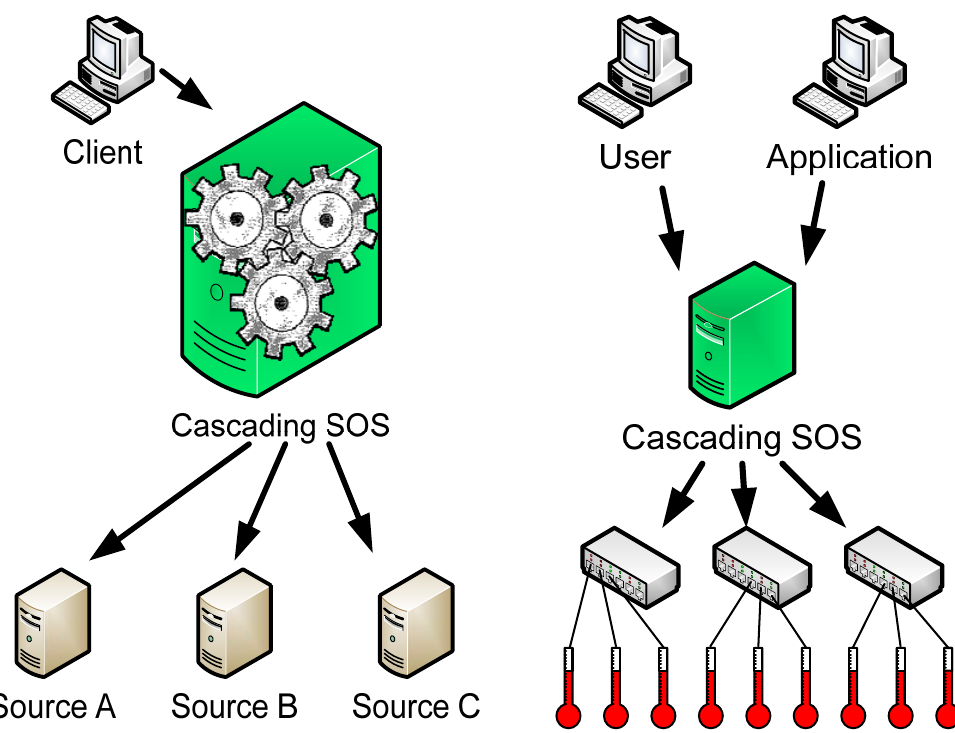
Figure 4. From left to right: (a) UC6 “Value Added SOS”; (b) UC2 “Sensor Data